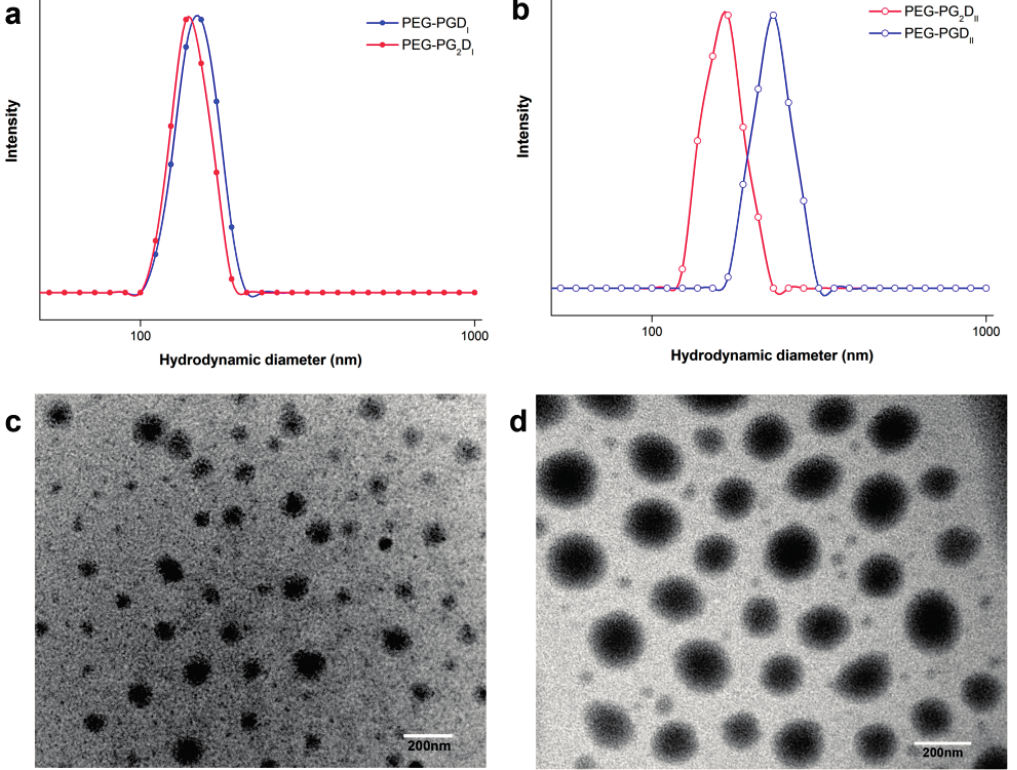
Figure 4. Particle size characterization of prepared micelles. The dynamic laser light scattering analysis of PEG-PGD and Y-shaped PEG-PG